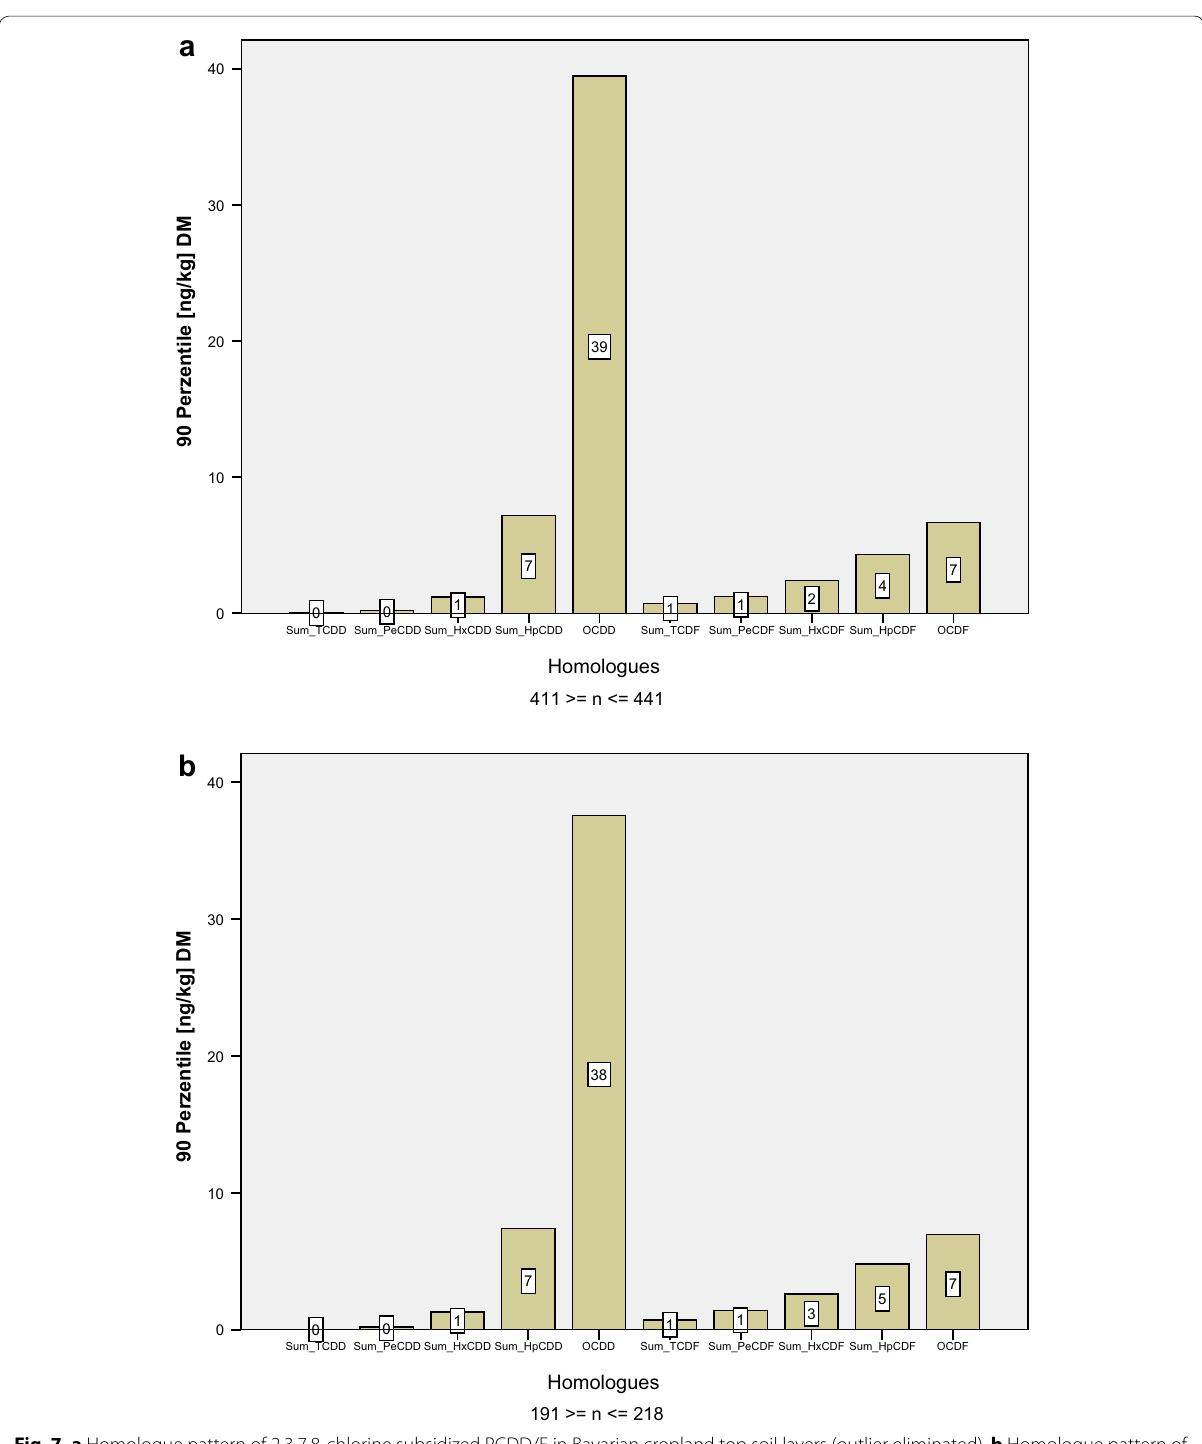
Fig. 7 a Homologue pattern of 2,3,7,8-chlorine subsidized PCDD/F in Bavarian cropland top soil layers (outlier eliminated). b Homologue pattern of 2,3,7,8-chlorine subsidized PCDD/F in Bavarian grassland top soil layers (outlier